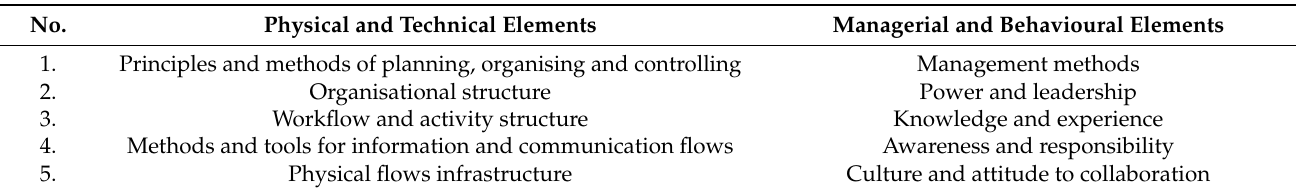
Table 2. The fundamental elements of compostable packaging waste